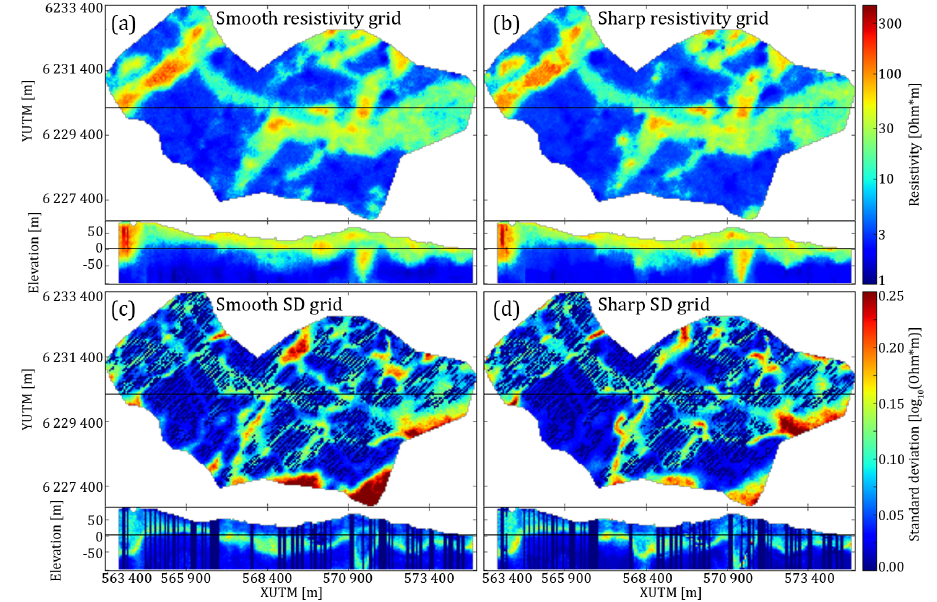
Figure 7. An overview of the key differences between reconstructing the resistivity grid using smooth and sharp inversion resistivity models. Each grid is portrayed as a horizontal slice at 20mb.s.l. and a vertical cross section intersecting at YUTM 6230100m. (a) shows the smooth reconstructed resistivity grid. (b) portrays the sharp reconstructed resistivity grid. (c) shows the standard deviation calculated from 50 stochastic reconstructions of the smooth resistivity grid. (d) shows the standard deviation calculated from 50 stochastic reconstructions of the sharp resistivity